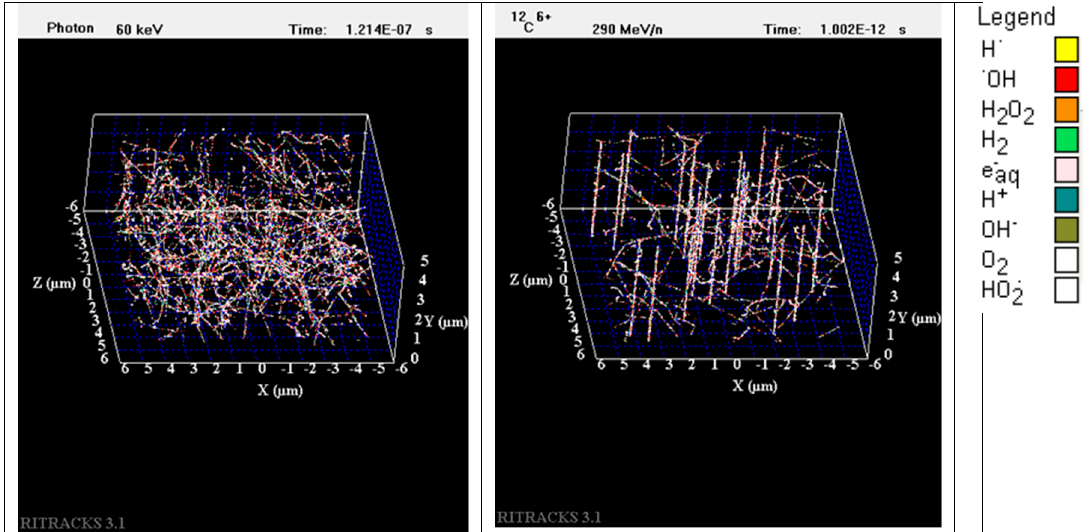
Figure 4. Simulation of the radiation track structures in a volume of 10 × 10 × 5 µ m 3 irradiated by 50 cGy of X-ray ( left ) and 50 cGy of carbon ion, 290 MeV/n ( right ). Each dot represents a radiolytic species (see legend for color code).